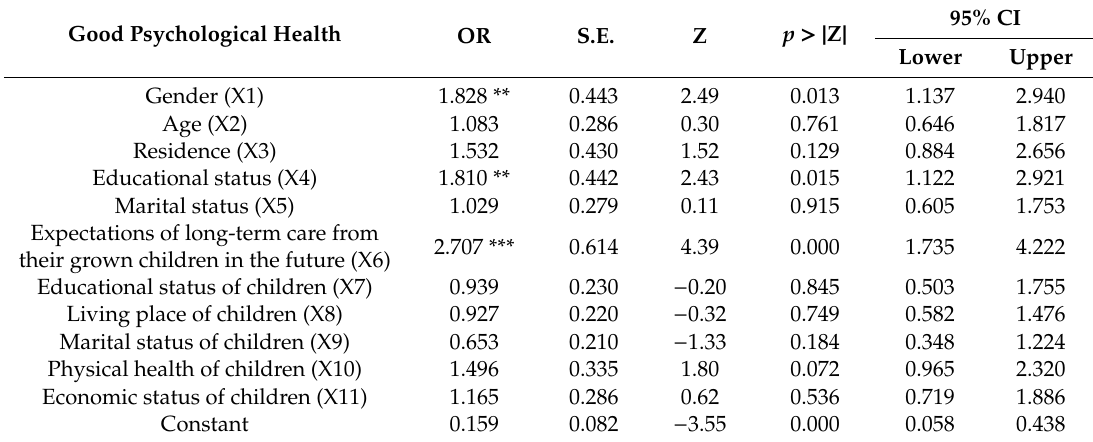
Table 2. Logistic regression results in the first step.